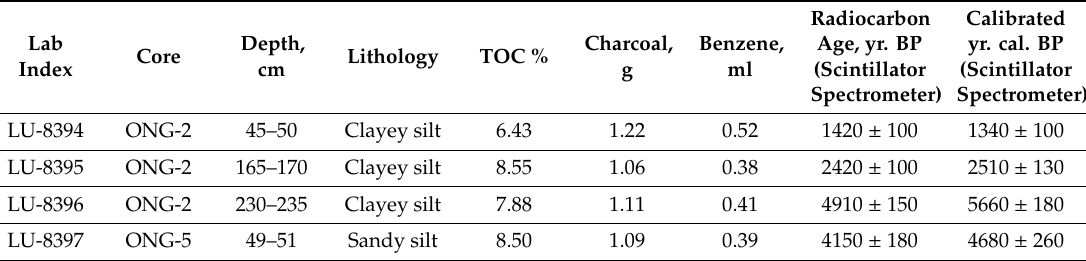
Table 2. Results of radiocarbon